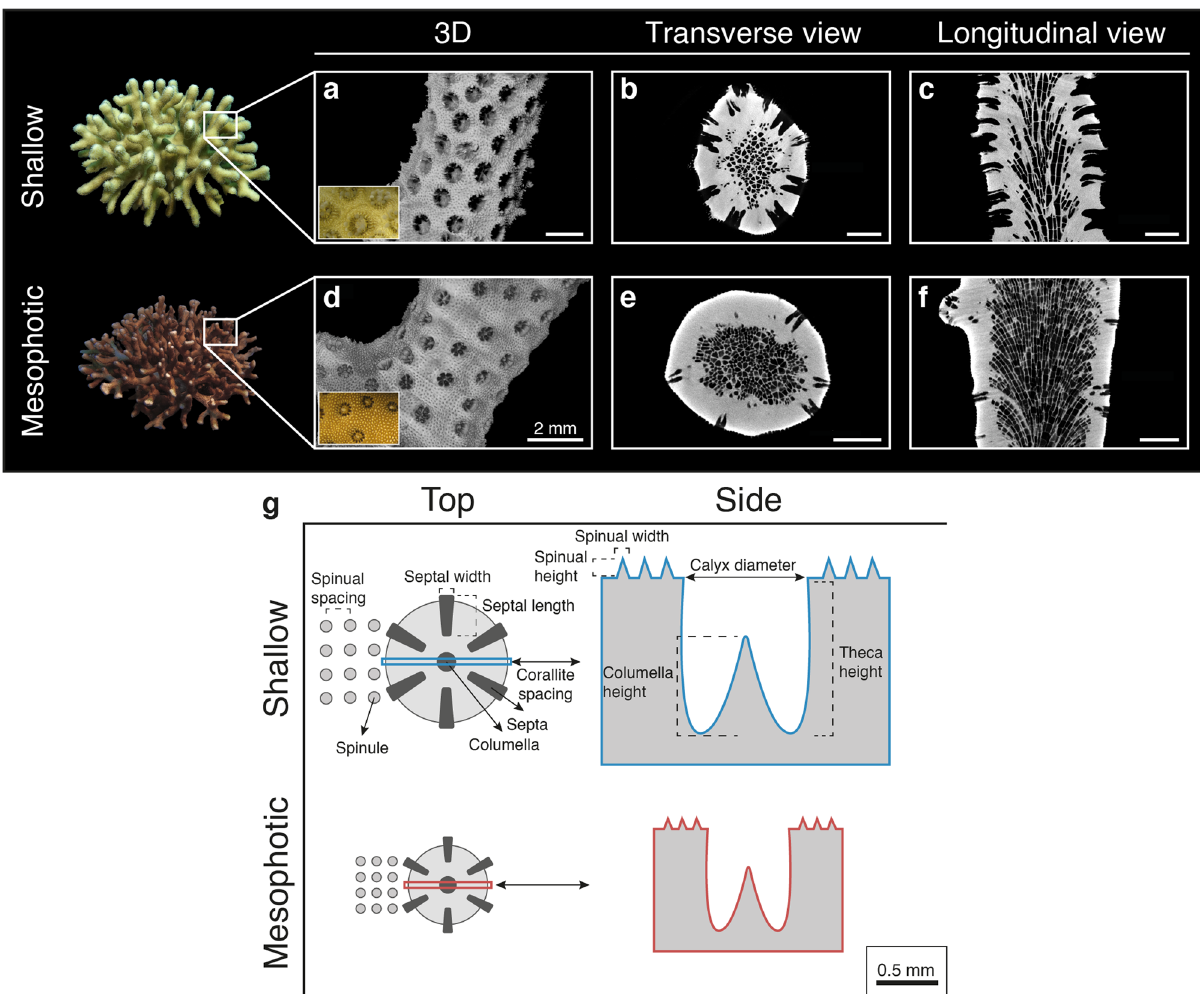
Fig. 1 Morphotypes of shallow and mesophotic S. pistillata . Examples of μ CT X-ray scans from a – c shallow and d – f mesophotic showing: a , d 3D reconstructions of the skeletons (inset photos show surface covered with live tissue) and sections of b , e transverse and c , f longitudinal scan slices. Scale bars are 2 mm. g Two-dimensional schematic representation of the top-down and side view of a corallite and its surrounding coenosarc between the studied shallow and mesophotic corals. Key skeletal structural elements are noted and scaled based on mean